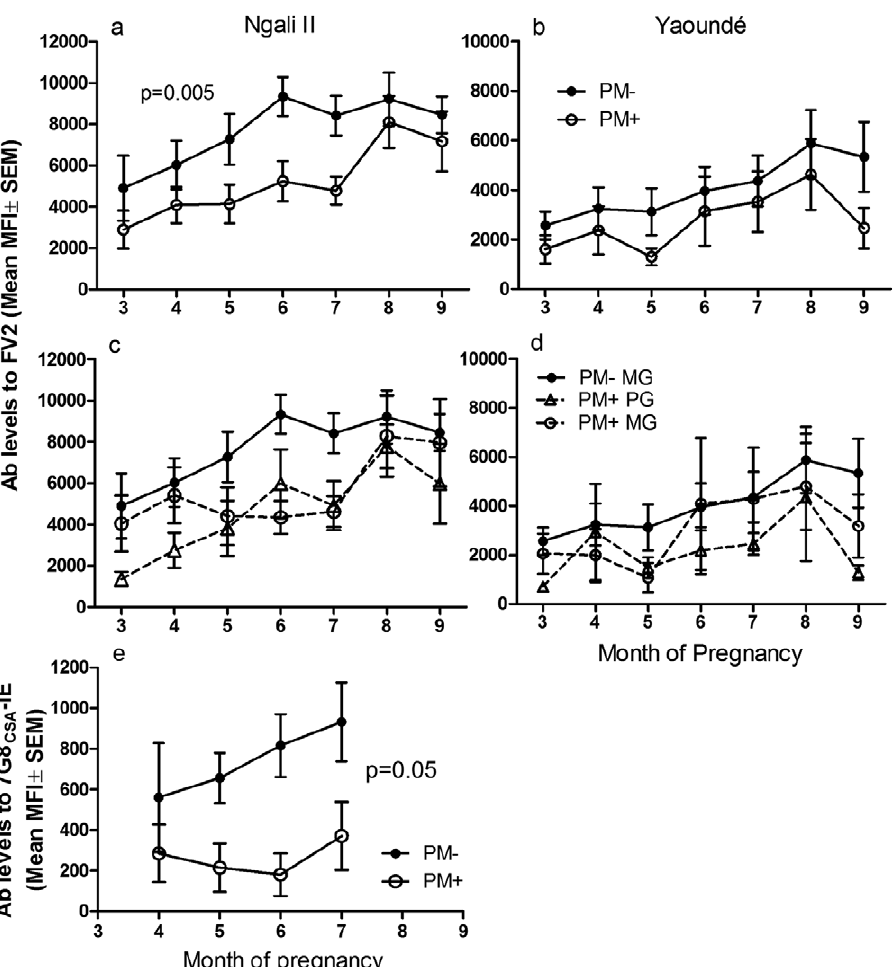
Figure 2. Correlation between Antibody Levels to VAR2CSA and Placental Malaria at Delivery. Anti-FV2 Ab levels (MFI 6 SEM) were determined between 3 to 9 months of pregnancy in women in Ngali II ( a ) and Yaounde´ ( b ) with known placental malaria status (Ngali II: PM 2 n=13, PM + n=14; Yaounde´: PM 2 n=10, PM + n=15). (a) A significant difference between PM 2 and PM + women in Ngali II was found throughout pregnancy using multilevel polynomial regression analysis (p=0.0047). ( b ) PM 2 women in Yaounde´ also had higher mean Ab levels compared to PM + women, although difference was not significant. ( c–d ) Data from PM 2 and PM + women were subdivided into primigravidae (PG) and multigravidae (MG). All PG in Ngali II and Yaounde´ were PM + at delivery, explaining why there are only 3 groups in the figures. Similar Ab levels were present in placental PM + PG and PM + MG. ( e ) The same plasma samples from PM 2 and PM + women in Ngali II collected at 4 to 7 months were tested for surface binding to CSA-binding IE (7G8 strain). In support of the results in Fig. 2a, higher levels of Ab was detected in women in Ngali II who were PM 2 compared to those who were PM + (p=0.05). P values are based on multilevel polynomial regression analysis. Abbreviations: FV2, full-length VAR2CSA; PM 2 , placental malaria-negative; PM + , placental malaria-positive; PG, primigravidae; MG,